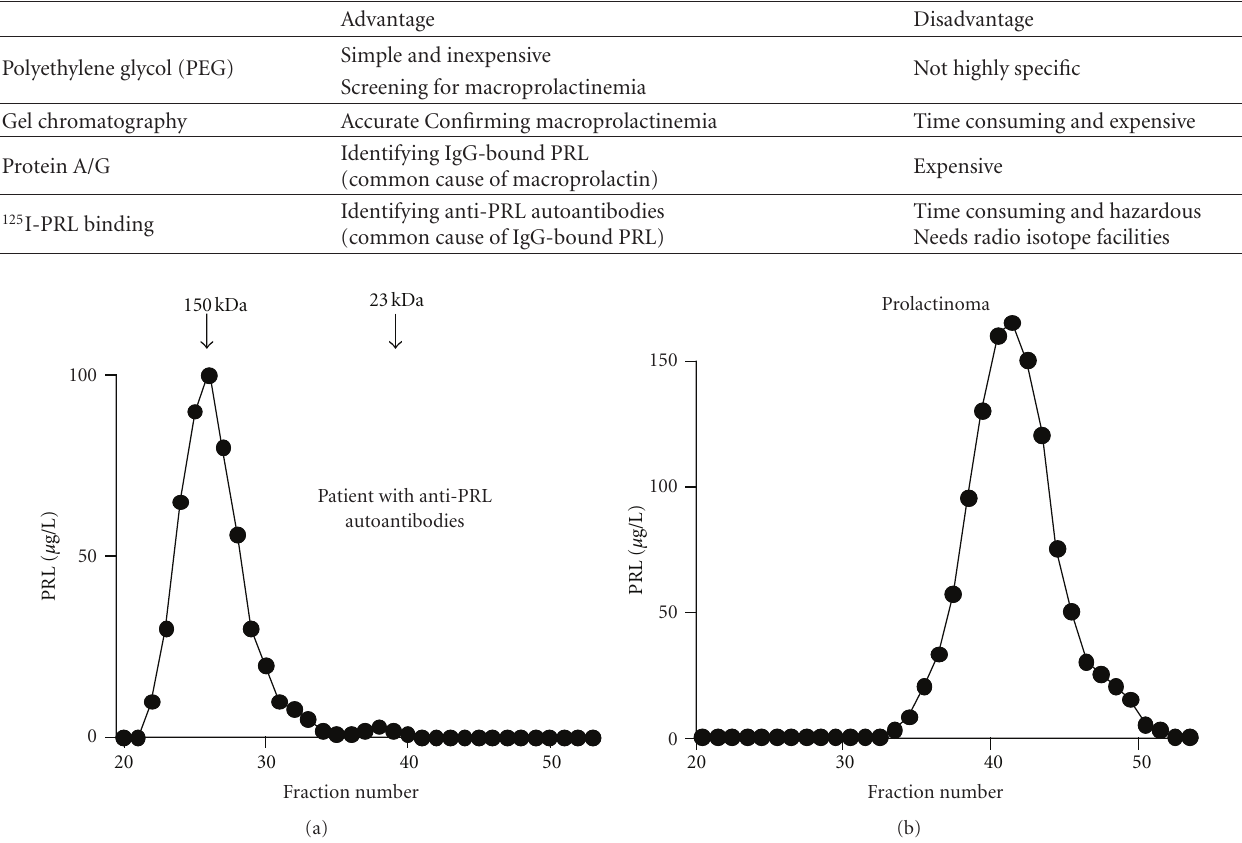
Figure 2: Gel filtration chromatography of macroprolactin and prolactin. Representative gel filtration chromatography of PRL in serum samples of macroprolactinemia (a) and prolactinoma (b). (Reproduced from